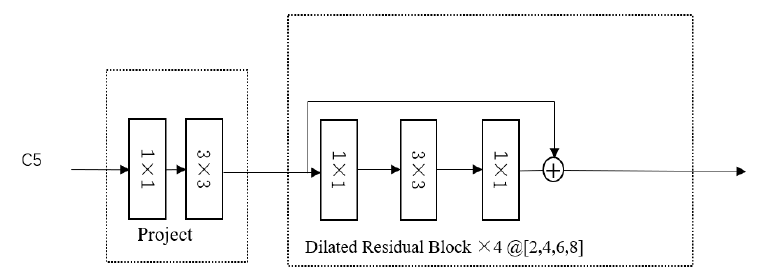
Figure 2. The single-layer feature map of YOLOF. C5 is a feature map from backbone in